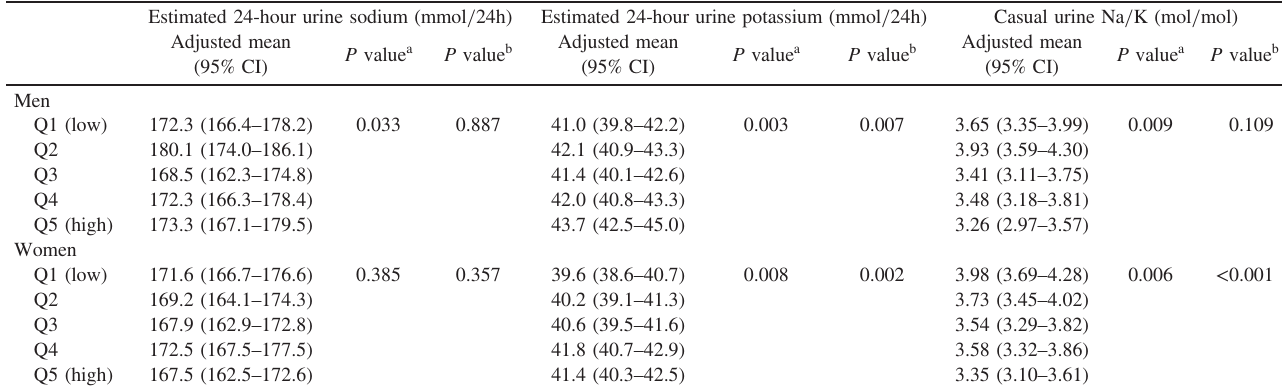
Table 2. Multivariable-adjusted means of estimated 24-hour urine sodium and potassium and casual urine Na / K according to quintiles of equivalent household expenditure by sex: NIPPON DATA2010